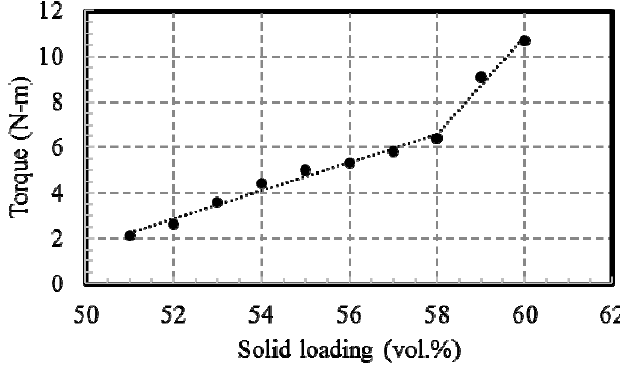
Figure 3. Results of the mixing torque measurement.